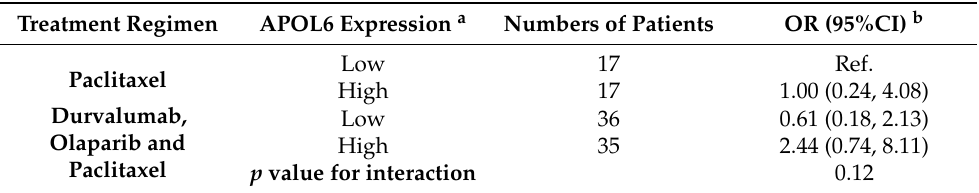
Table 2. Effects of APOL6 expression on pathologic complete response according to treatment regimen in HER2-negative stage II/III breast